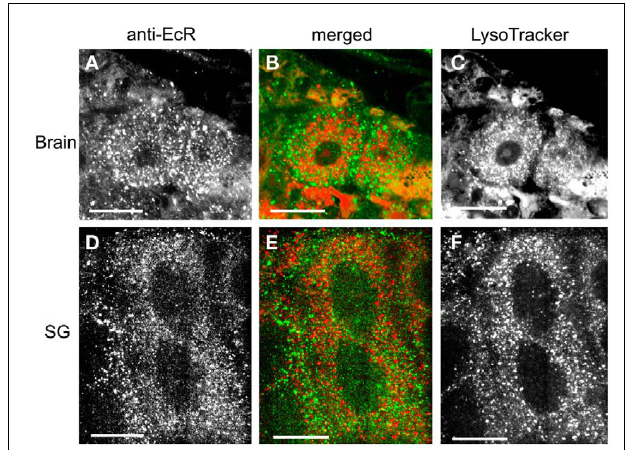
FIGURE 11 | Cells double-labeled with anti-EcR (left column, green) and LysoTracker (right column, red). The middle column shows merged images of left and right. Brain neurons (A–C) and SG cells (D–F) . Note the low level of co-localization in the merged images in the middle column. EcR fluorescence and fluorescence from LysoTracker labeling are shown as distinct red and green dots in the cytoplasm. Scale bars = 10 μ m.